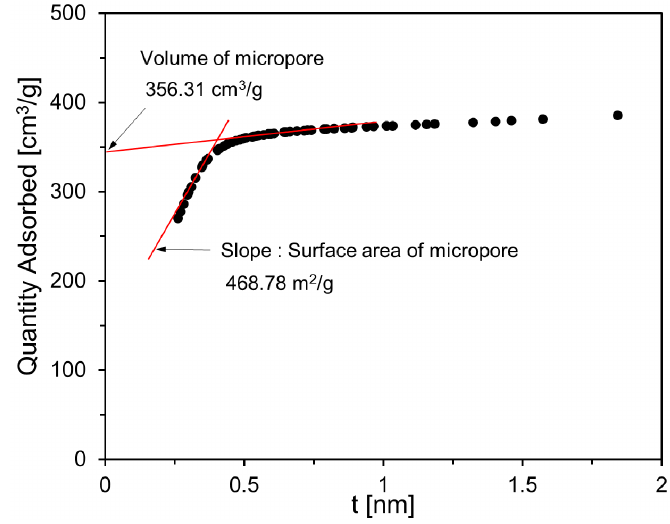
Figure 3. Micropore volume and micropore surface area of activated carbon.